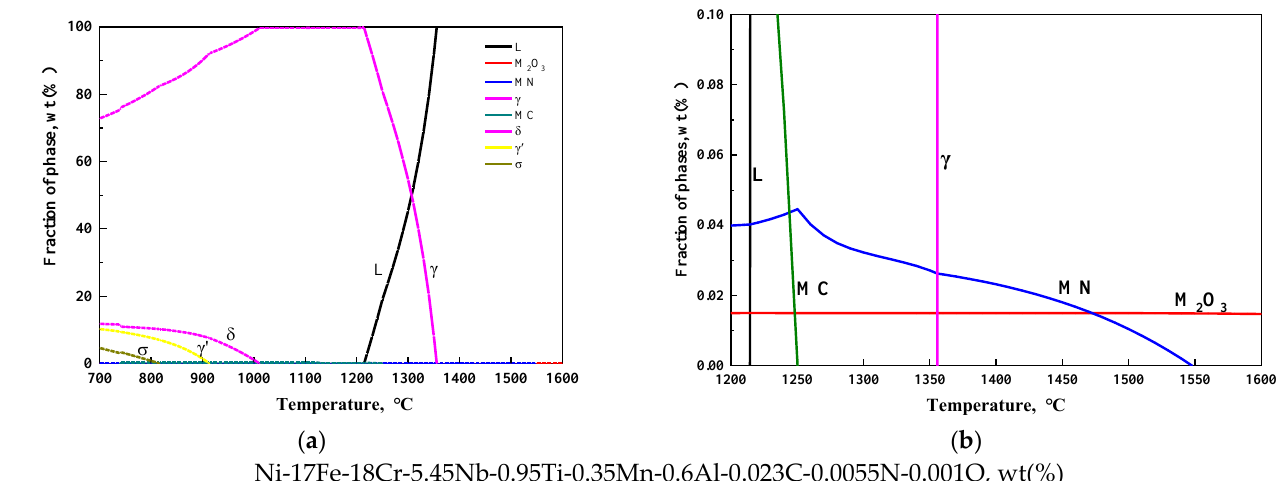
Figure 8. ( a ) Change of phases fraction in GH 4169 superalloy with temperature, and ( b ) local enlargement of precipitation phase.